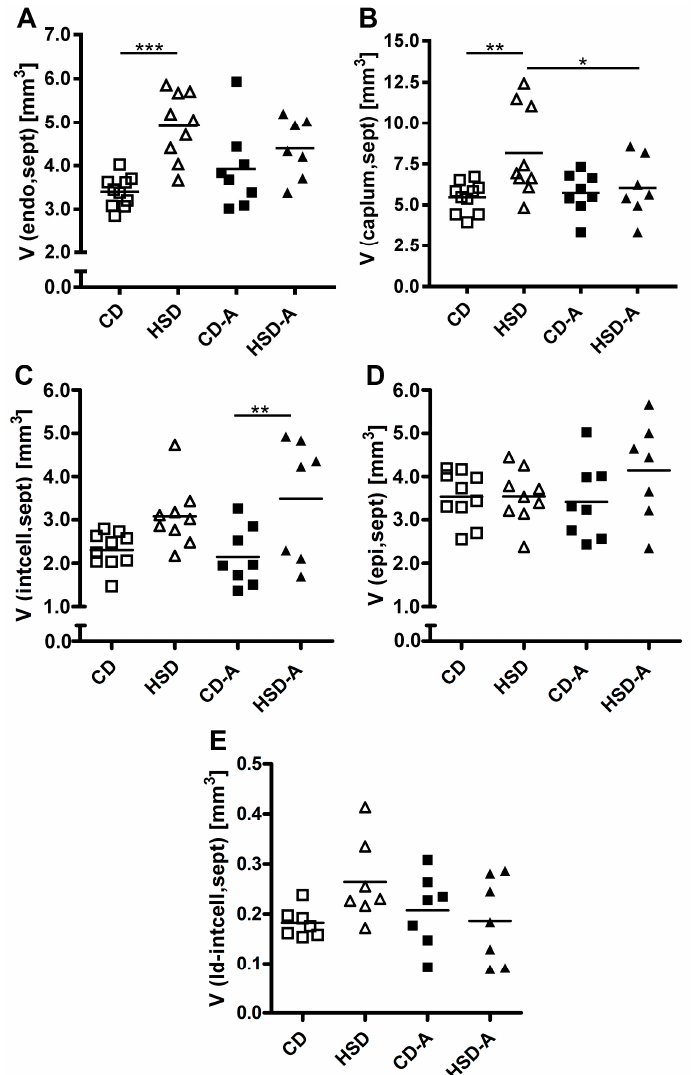
Figure 4. Effects of high sucrose intake and voluntary activity on septal composition. Mice were fed a control diet (CD) or a high sucrose diet (HSD) and were left untreated or had access to running wheels (CD-A, HSD-A) for 30 weeks. A) Volume of septal endothelial cells; B) Volume of septal capillary lumen; C) Volume of septal interstitial cells; D) Volume of septal epithelial cells; E) Volume of lipid droplets within septal interstitial cells. Values are individual data points, with means indicated by horizontal lines. Data were compared by 2-Way ANOVA followed by Tukey test; p -values < 0.05 are indicated: * p < 0.05, ** p < 0.01, *** p < 0.001.